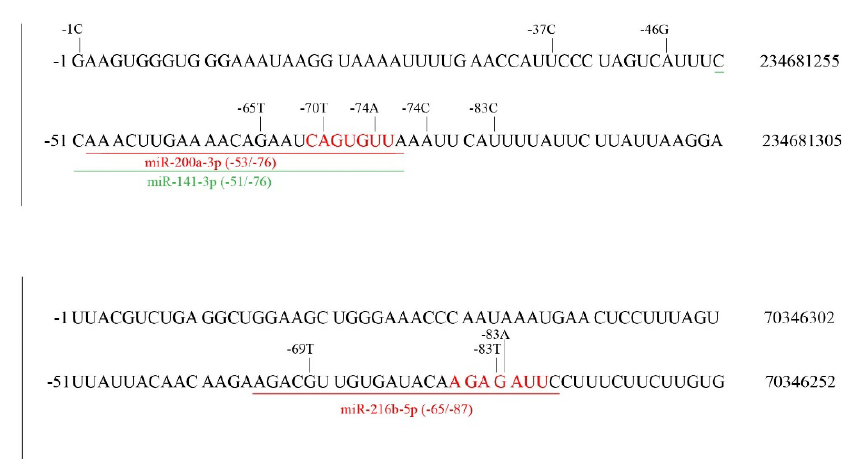
Figure 7. Somatic mutations within known miRNA seed target sites in UGT 3′UTRs in TCGA tumors. Data shown are the first 100 nt sequence of the 3′ UTR region for UGT1A ( A ) or UGT2B4 ( B ) with positions indicated at the cDNA (left, positioned as −1 for the nucleotide immediately following the stop codon) and genomic (GRCh37/hg19) (right) levels. Somatic mutations within miRNA target sites are given above the sequences. Underlined sequences are known target sites for miR-200a-3p (RED) and miR-141-3p (GREEN) in the UGT1A 3′UTR ( A ) and miR-216-5p (RED) in the UGT2B4 3′UTR ( B ). The miRNA positions are given in BRACKETs, and the miRNA seed target sites are highlighted in RED ( A , B ).